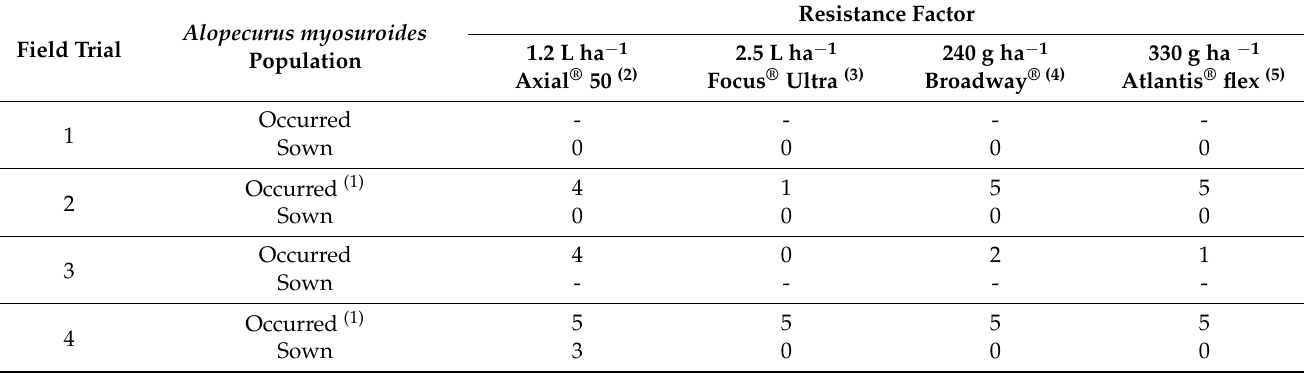
Table 3. Resistance characterization of the occurred and sown A. myosuroides populations in the four field trials (0: herbicide susceptible; 5: high resistance factor, -: no infestation or sown A. myosuroides